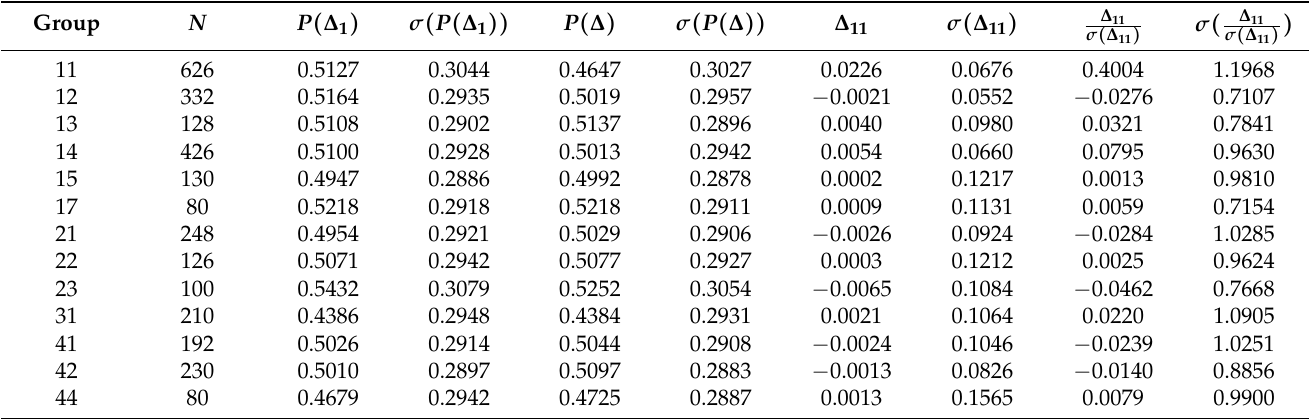
Table 10. Result of the numerical simulations—mean values of η angle statistical tests with standard deviations—part